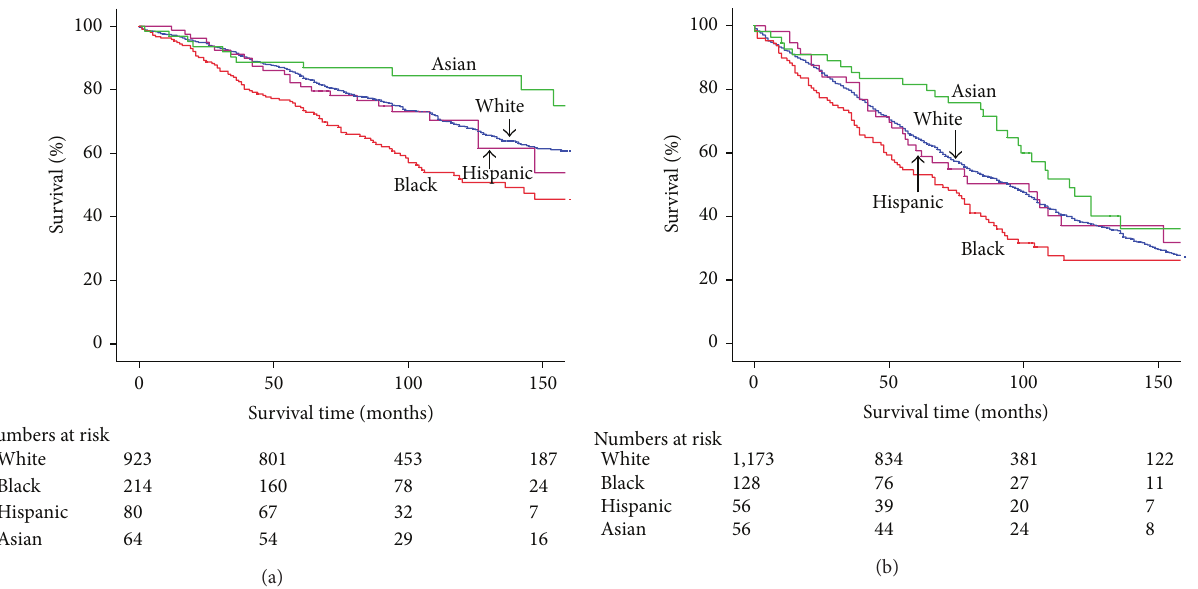
Figure 2: (a) Kaplan-Meier overall survival by race: < 65 years. (b) Kaplan-Meier overall survival by race: ≥ 65